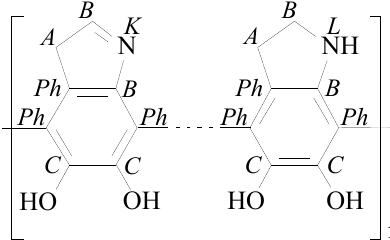
Figure 5. Characteristic cutouts from the chemical structure of PDA. Italic letters denote the assignment of the carbon and nitrogen atoms to the component peaks in the C 1s and N 1s high- resolution spectra.